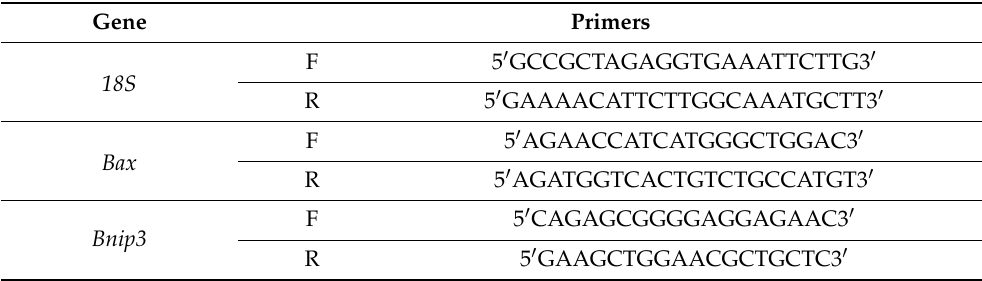
Table 1. Apoptotic gene primers used for